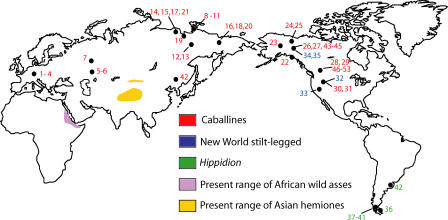
Provenance of Bone Samples Extracted and Sequenced for This StudyDetails of each sample are given in Table S2.